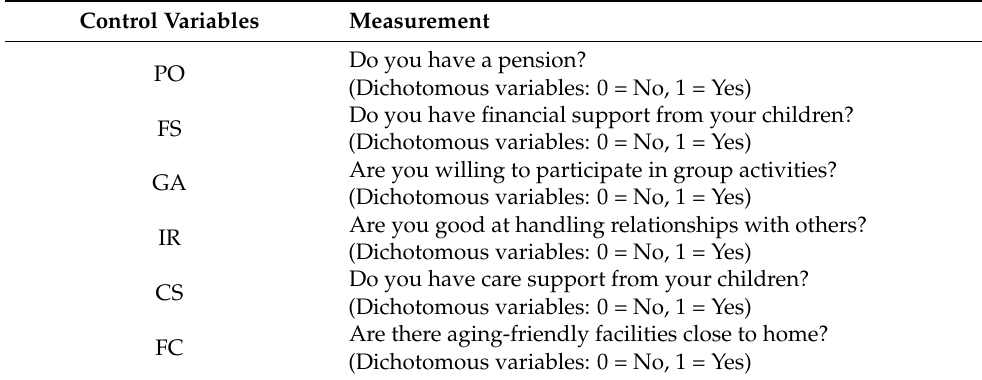
Table 4. Measurements of the control variables.